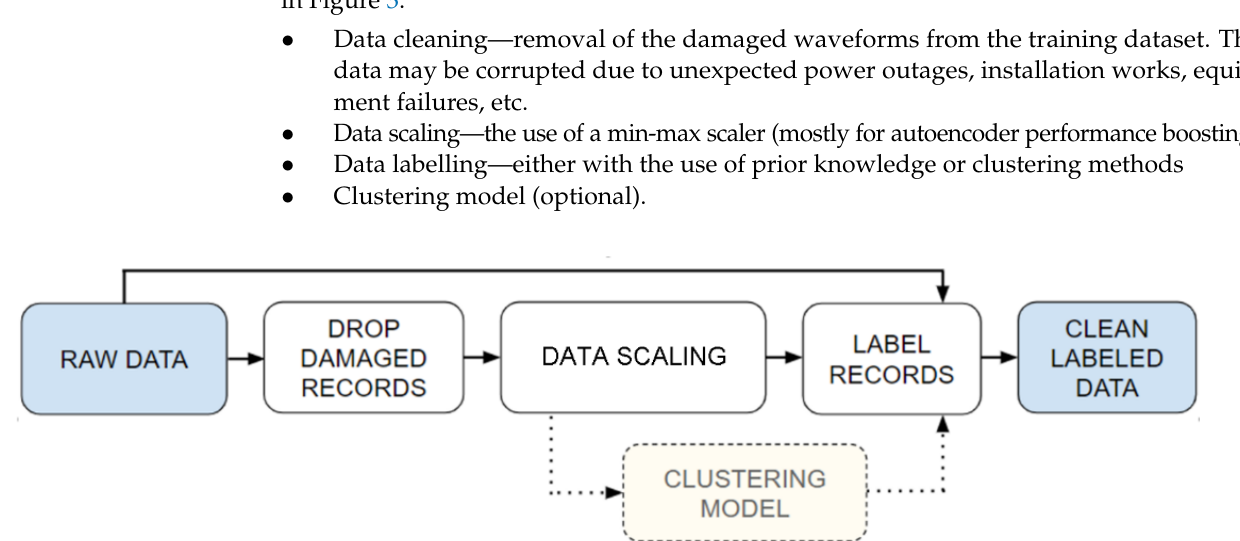
3.2. Data Scaling and Labelling The second step was data scaling so that algorithms such as neural networks will not favour larger values over smaller ones (where both are equally significant). The scaler used in the application is a MinMax scaler (8) and its formula is as follows